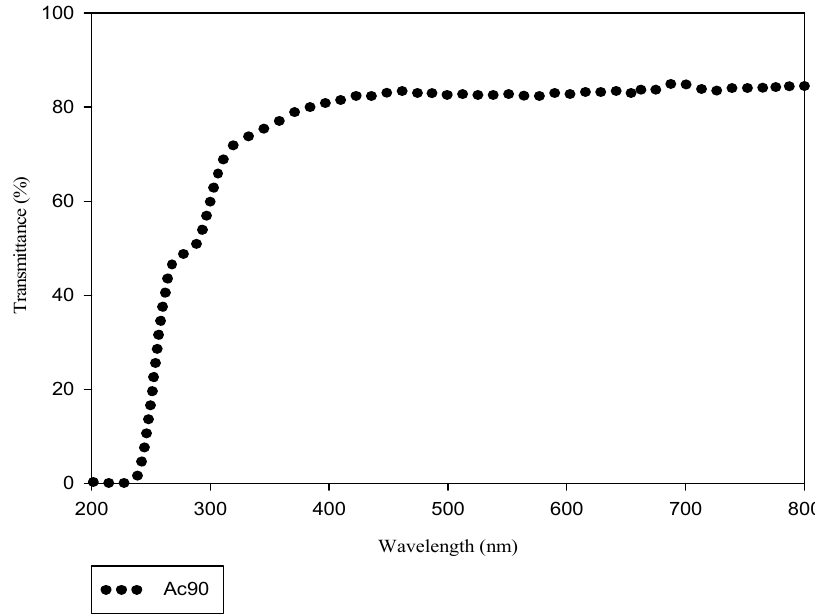
Figure 4. Light transmittance of Ac90 cellulose film.